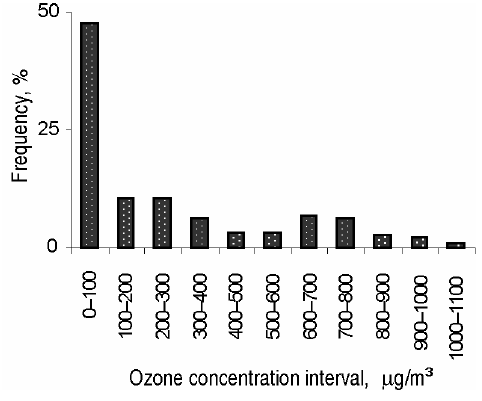
Fig 5. Distribution of ozone concentration frequency in room